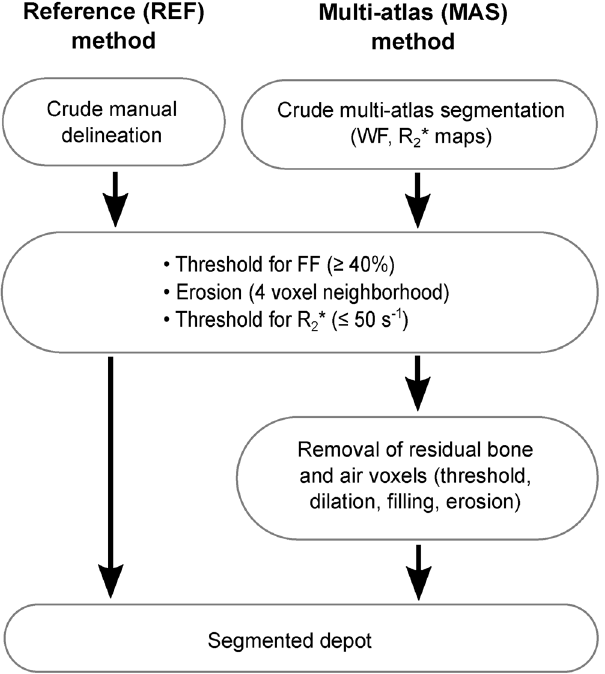
Figure 1. Flow charts of the semi-automated reference segmentation (REF) method and the automated multi-atlas segmentation (MAS) method. In the MAS method, the initial crude manual delineation of the REF method was replaced by a crude multi-atlas segmentation. Thereafter, a common set of automated fine adjustments was applied to the two methods (thresholding, erosion). In the MAS method, the segmented depot was obtained after a refinement step where residual voxels of air and bone were removed (by thresholding, dilation, filling of holes, erosion). In the REF method, the segmented depot was obtained directly after the automated fine adjustments as voxels in bone and air were assumed to be avoided in the manual